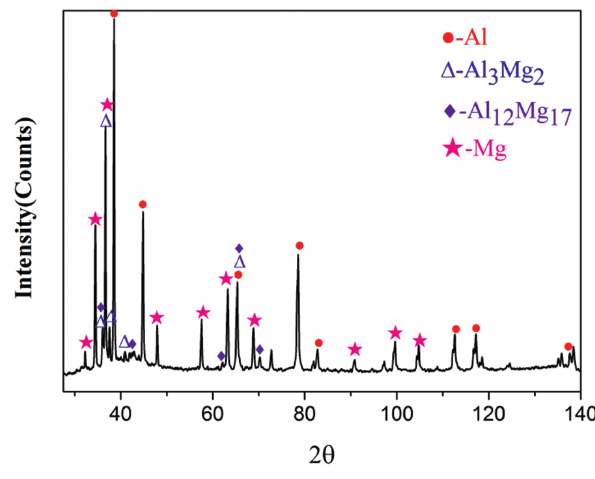
Figure 2: The selected area XRD result of the Mg/Al bonded